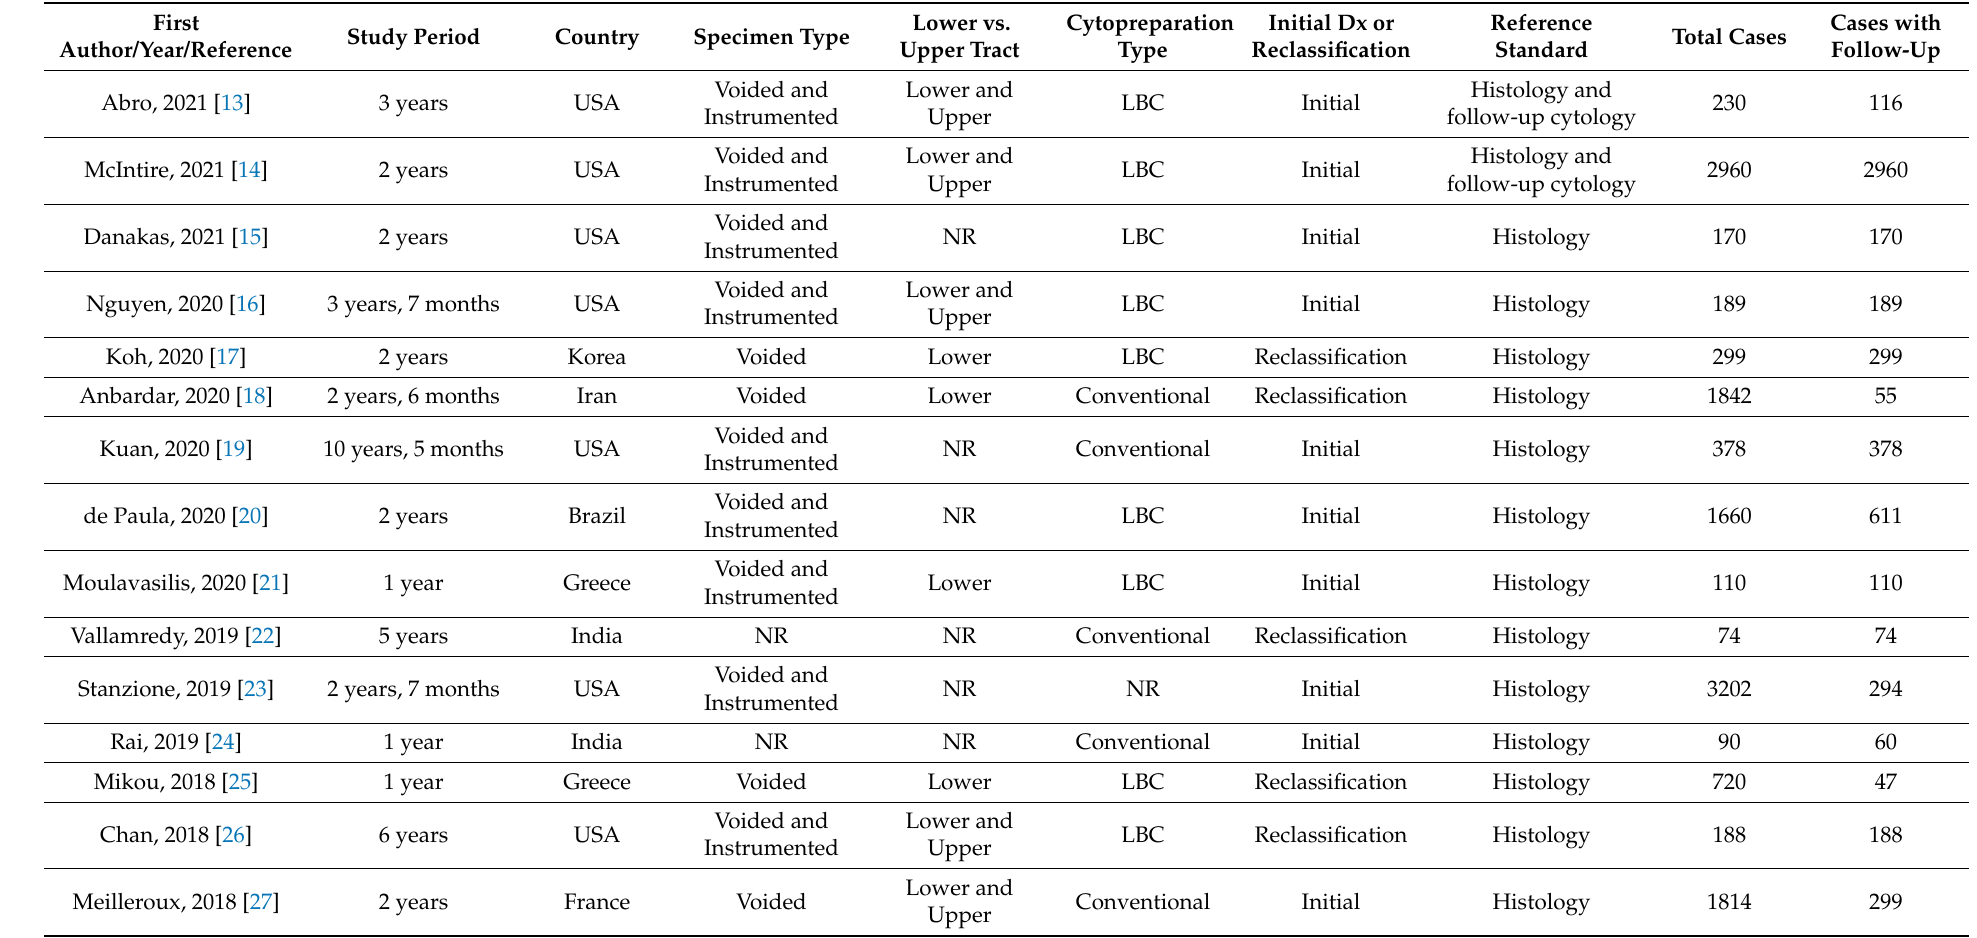
Table 1. Main characteristics of the studies included in the